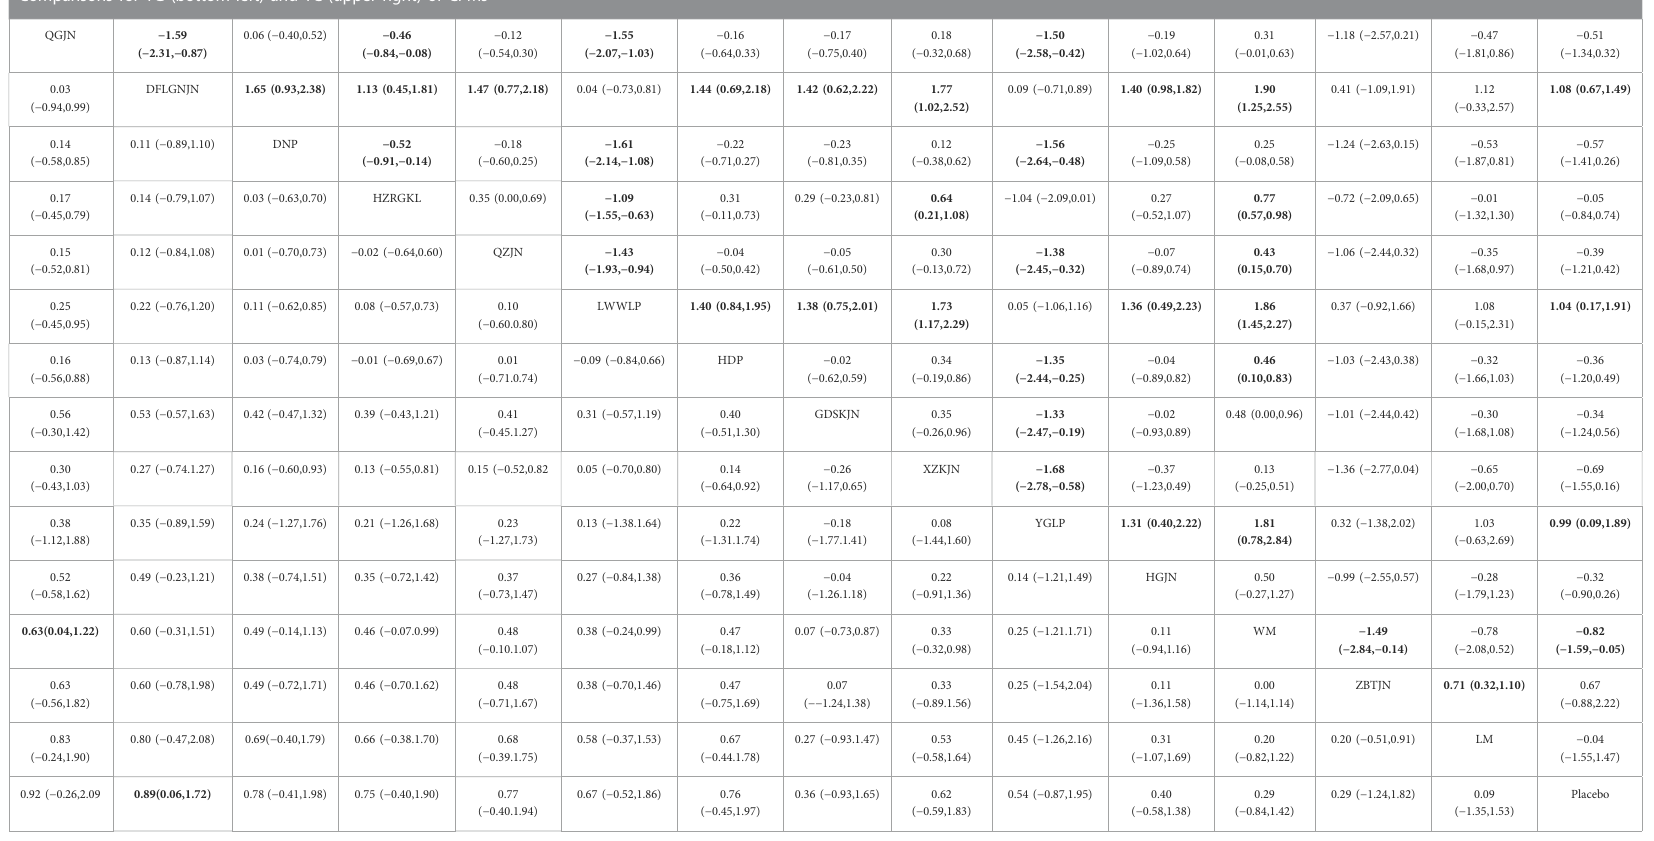
TABLE 4 The league table of TG and TC. Comparisons for TG (bottom left) and TC (upper right) of